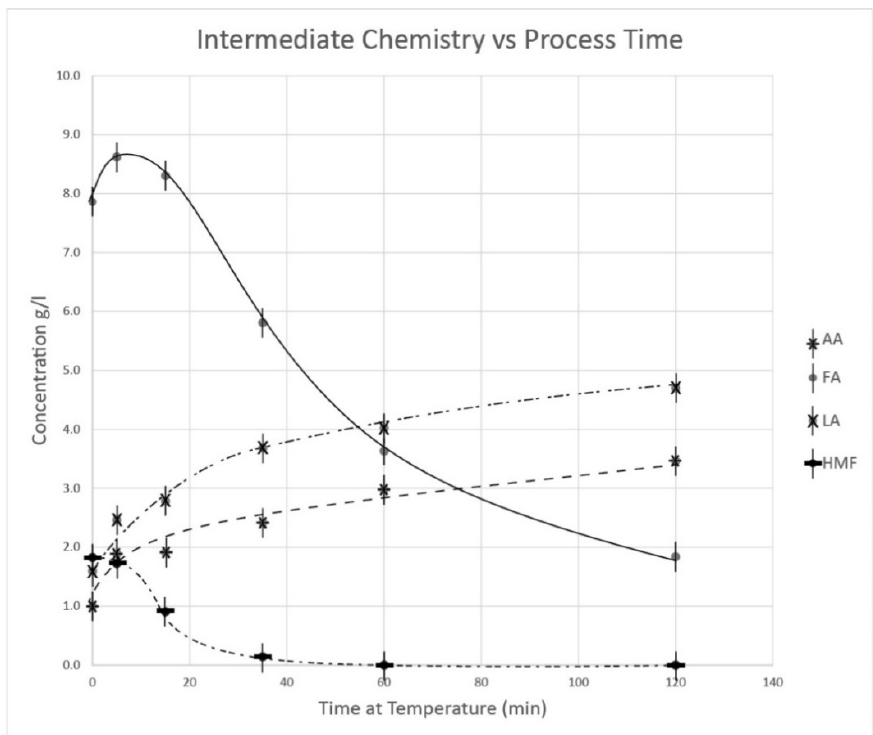
Figure 9. Concentration of intermediates in HTP catalyst from wood as a function of time. The HTP catalyst concentration was 2 g / L.